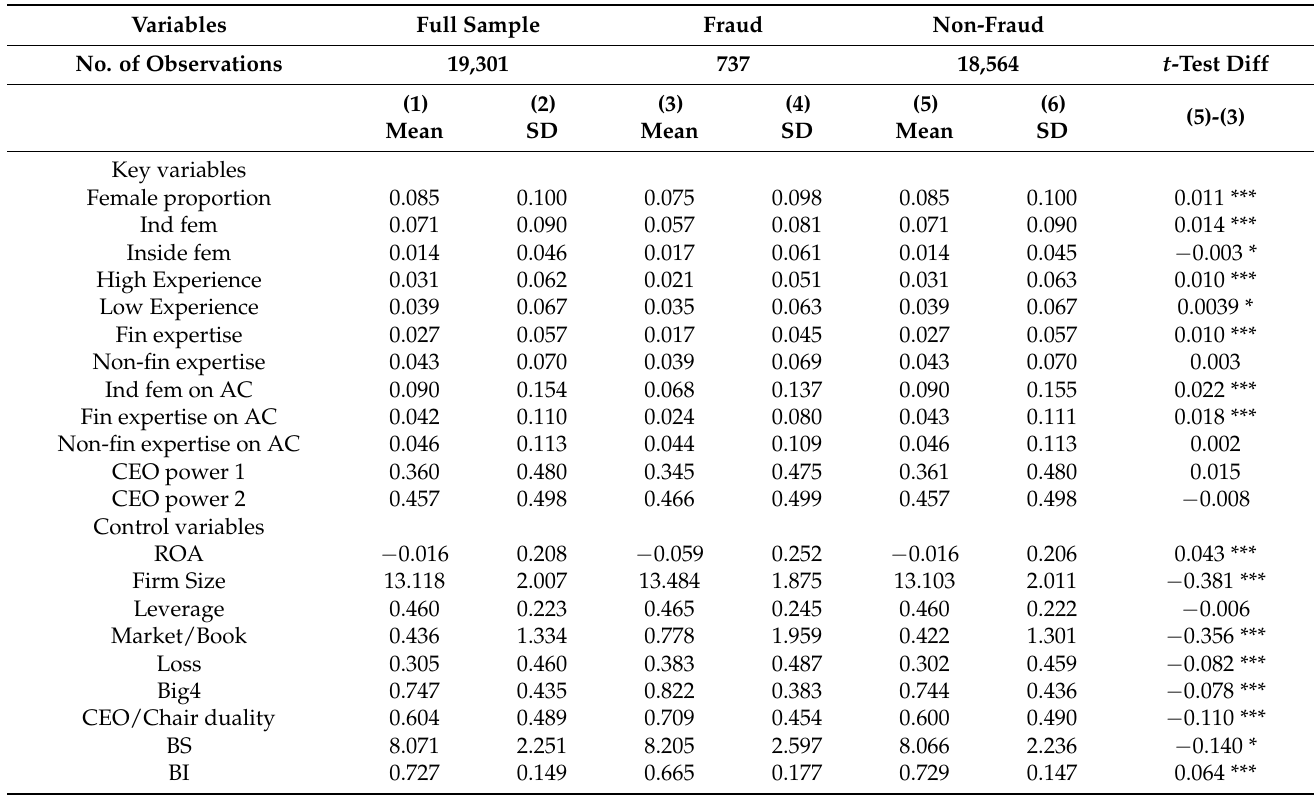
Table 3. t -Tests for mean differences between fraud and non-fraud